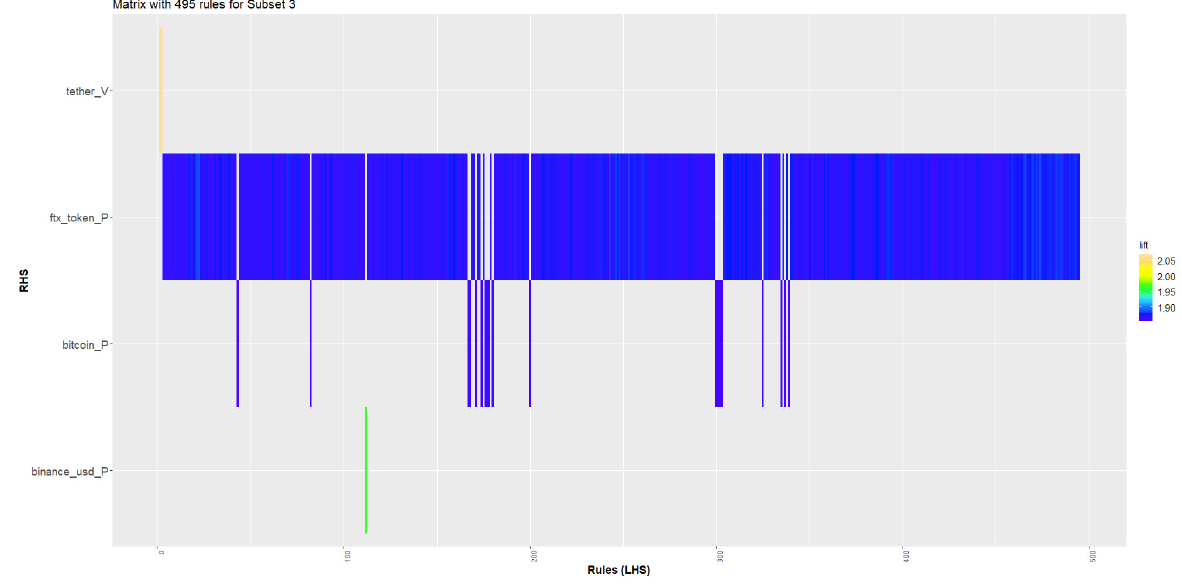
Figure 8. Matrix-based plot for Subset